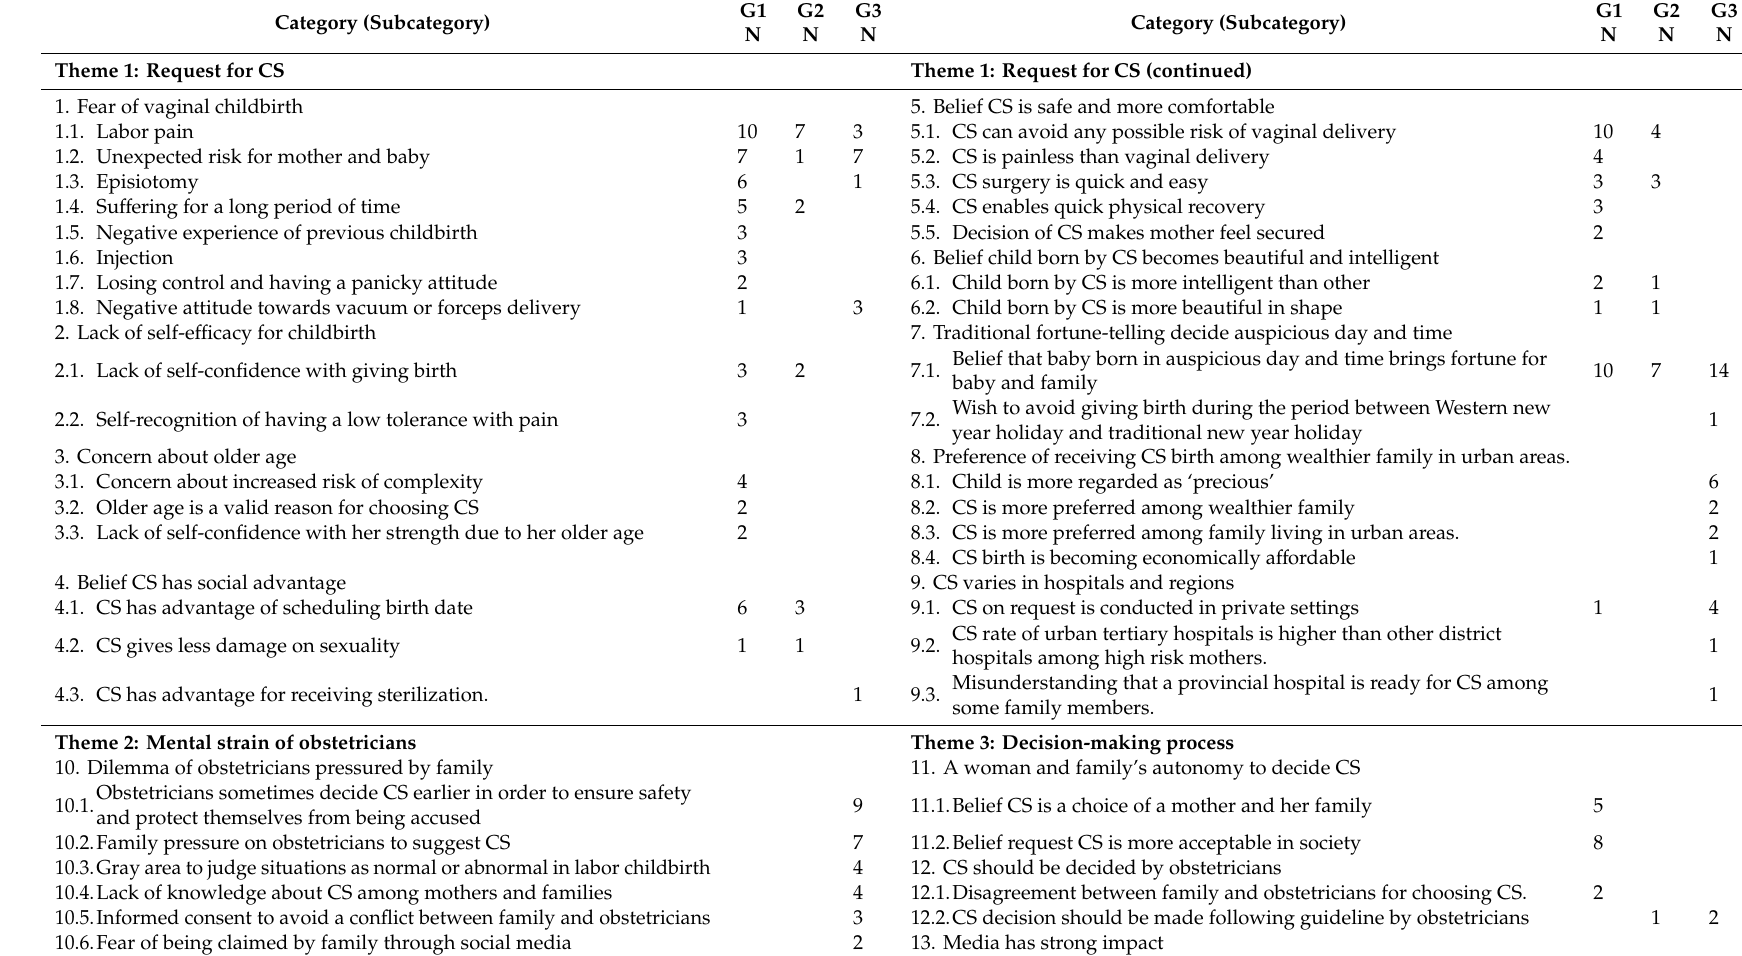
Table 2. Social factors for increased